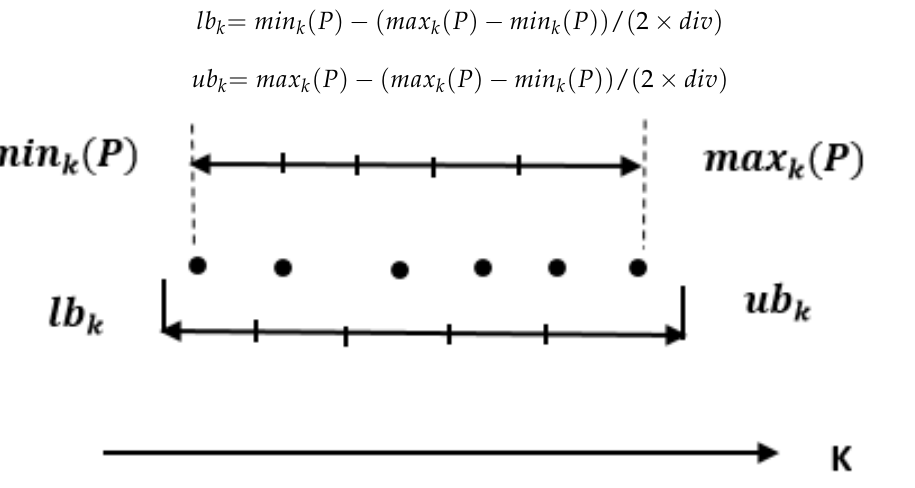
Figure 1. Grid setting for the kth objective [25].